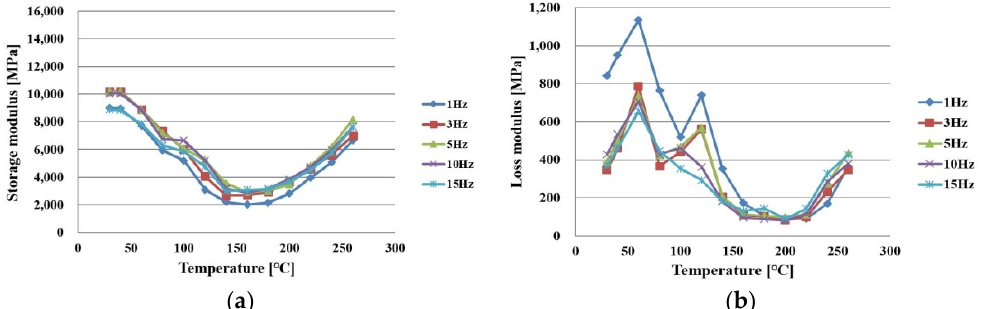
Figure 7. Measurement results of PPG in an x direction under curing as a function of frequency: ( a ) storage modulus; ( b ) loss modulus.